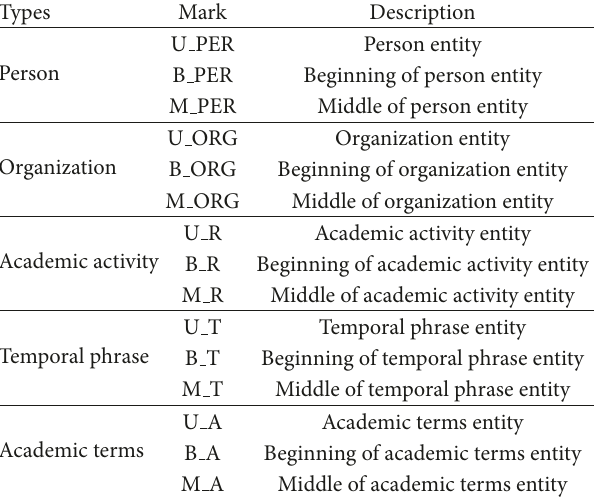
Table 1: Entity tag